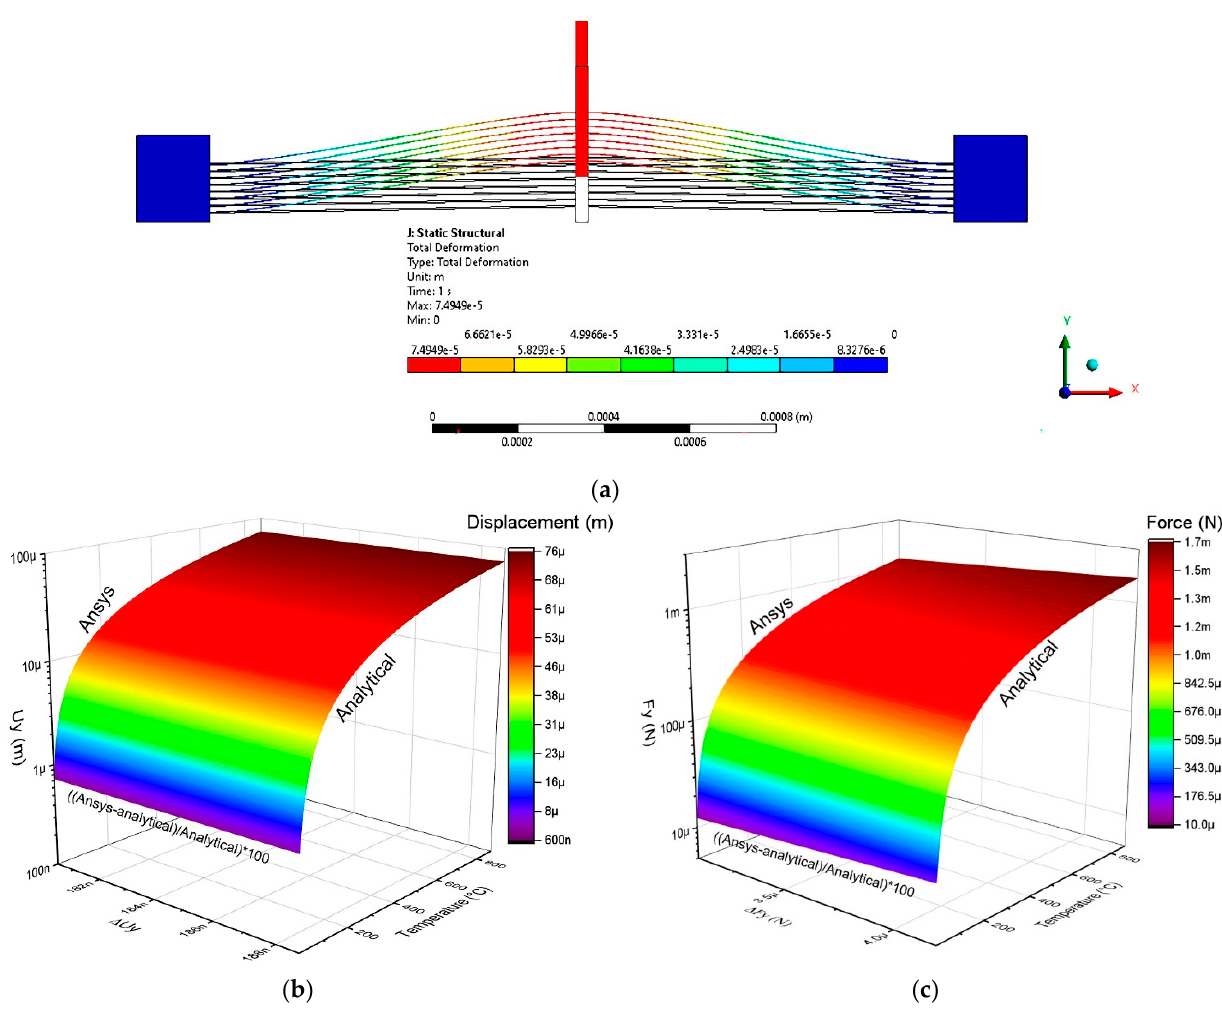
Figure 9. Simulation results of V-shaped microactuator. ( a ) Displacement at 2 V. ( b ) Displacement and ( c ) force responses under voltage sweep from 0 V up to 2 V.